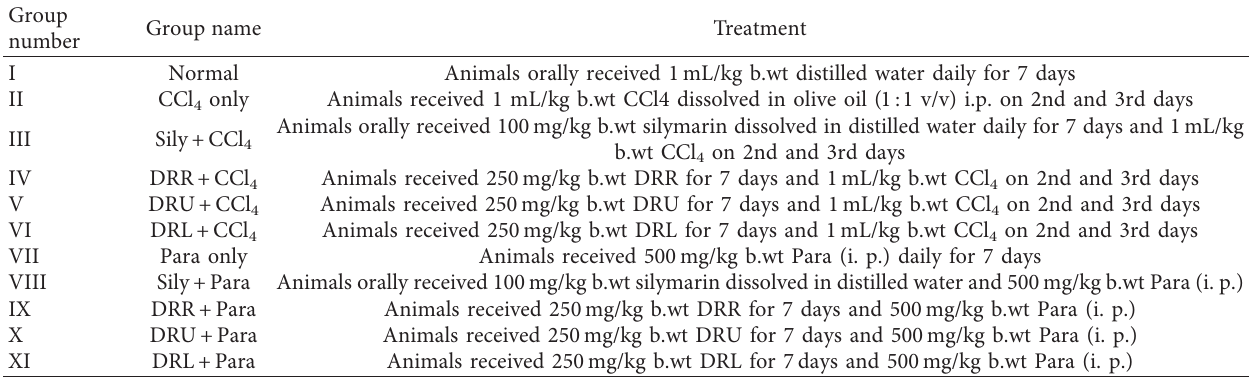
Table 1: Grouping of animals for the